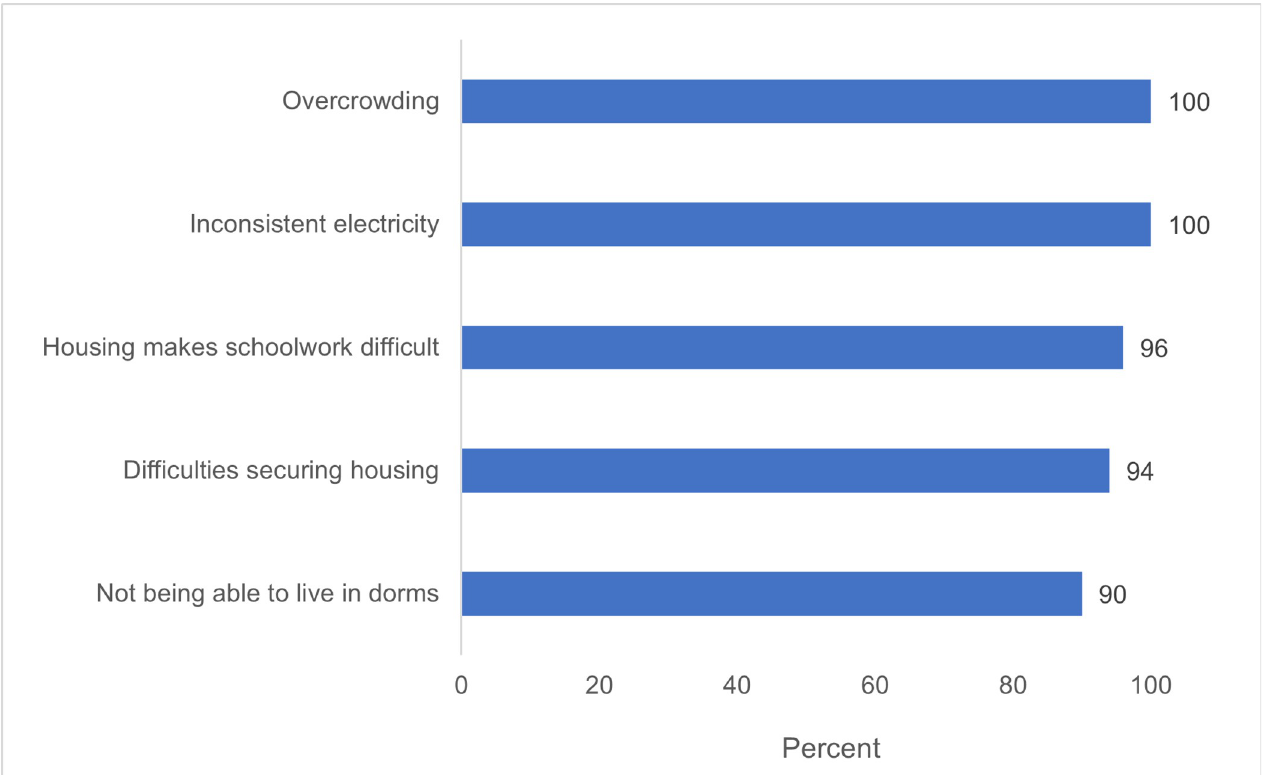
Fig 3. Percentage of students who experienced the following conditions in medical school dorms (2016).